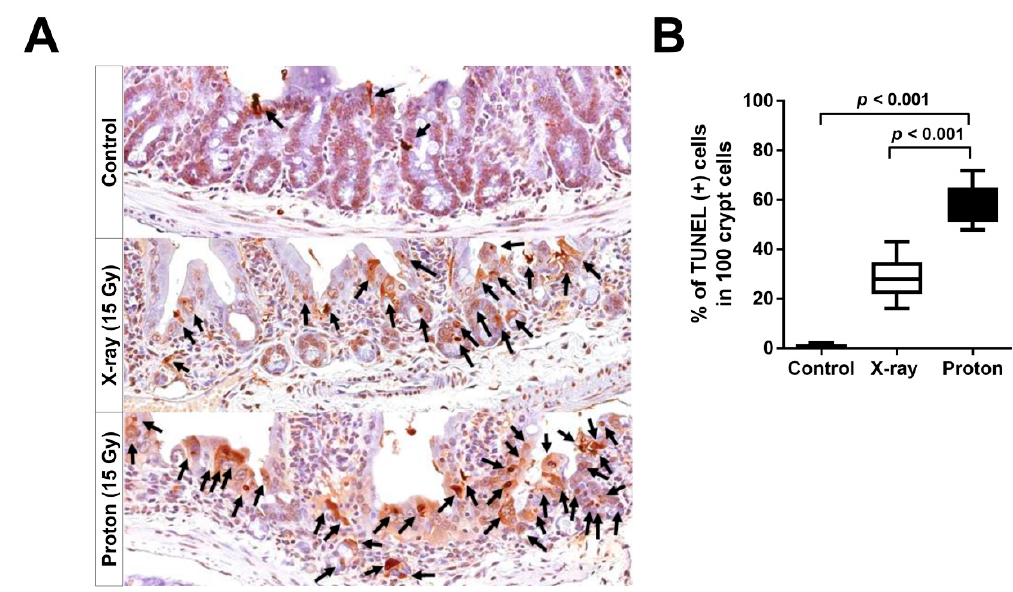
Figure 5. Proton irradiation is more effective in inducing apoptotic cell death in the jejunal crypts than X-ray irradiation. ( A ) The representative terminal deoxynucleotidyl transferase-mediated dUTP nick-end labelling (TUNEL) IHC images of the jejunum sections 3.5 days postirradiation are presented herein. The black arrows indicate TUNEL-positive cells in the crypts. ( B ) The box and whisker plots represent the percentage of TUNEL-positive cells in the irradiated crypts.